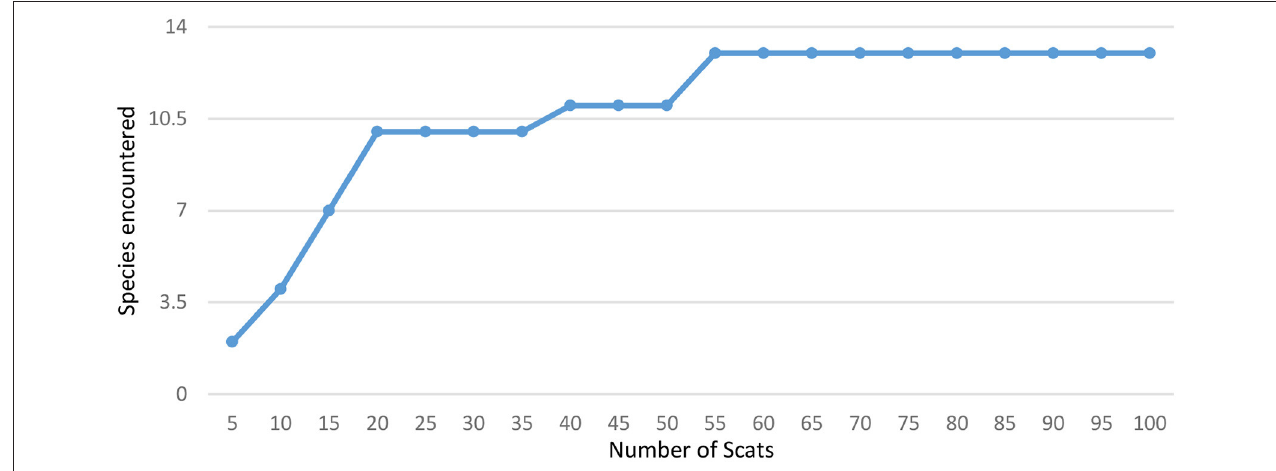
FIGURE 2 | Accumulation curve for prey species found in leopard scats collected from Sanjay Gandhi National Park in 2015.